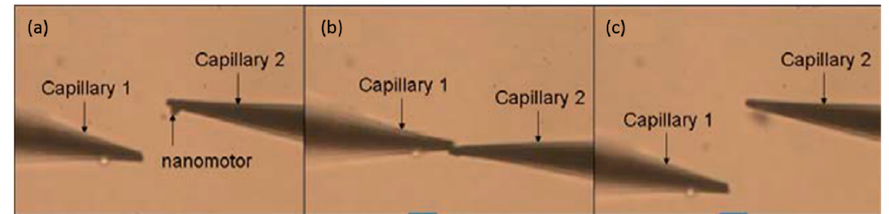
Figure 7. The release process of nanorobot. ( a ) The nanorobot is adhered to capillary 2. ( b ) Pressing capillary 2 with capillary 1 makes it bend. ( c ) Releasing capillary 2 makes it vibrate, and the nanorobot is released from capillary 2. After the releasing of nanorobot, hydrogen peroxide solution was added into the water to obtain the desired concentration.